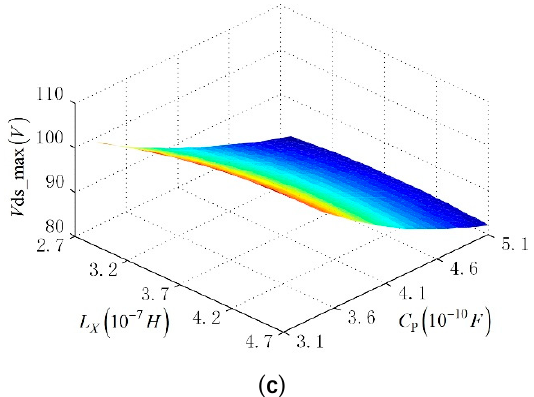
Figure 3. ( a ) Output power of RFC changing with L x and C p ; ( b ) output efficiency of RFC changing with L x and C p ; ( c ) peak voltage of RFC changing with L x and C p .